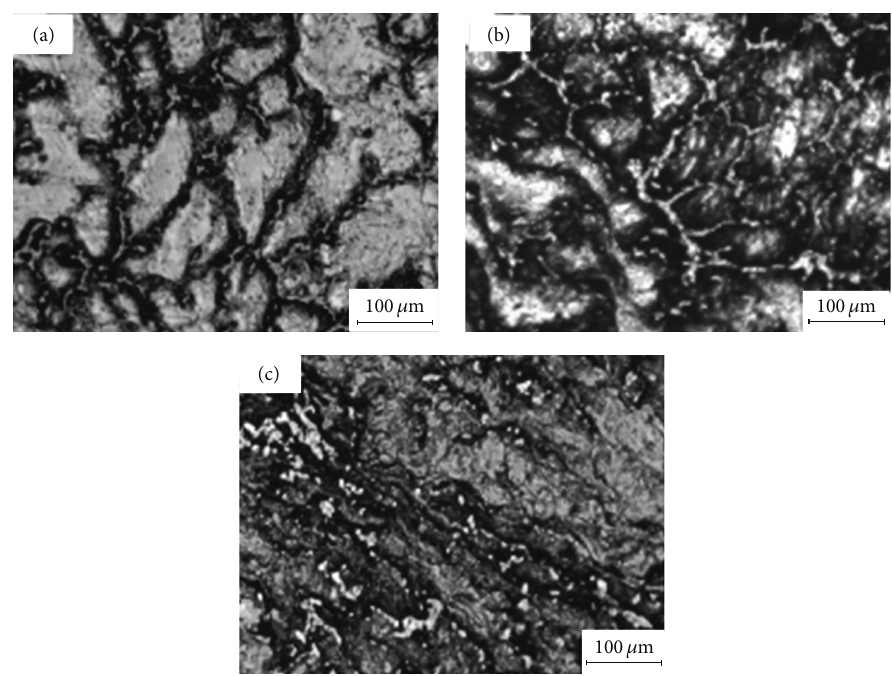
Figure 2: Microstructure of AZ81 magnesium alloy at 300 ∘ C. 𝜀 = (a) 50%, (b) 75%, and (c) 90%.